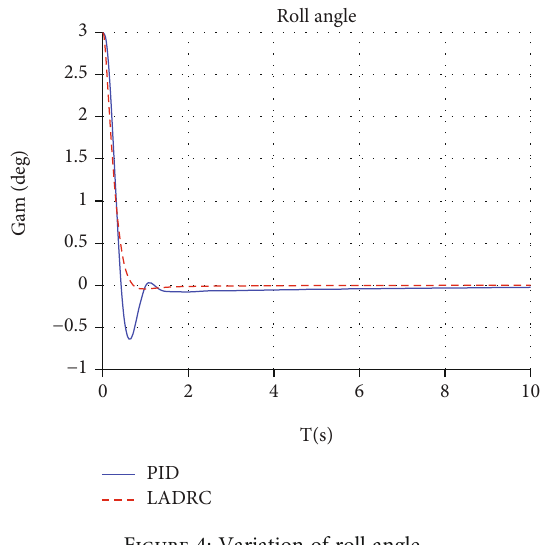
Figure 6: LESO attitude angle velocity estimation